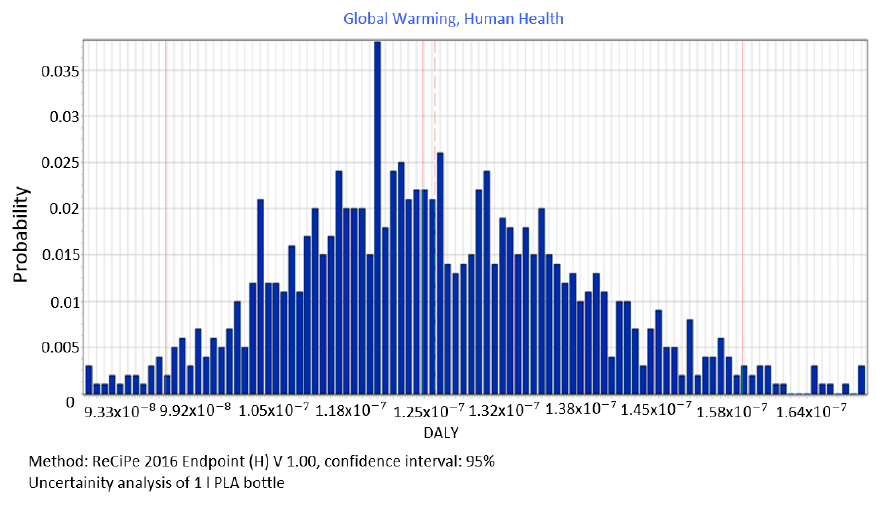
Figure 9. Results of the uncertainty analysis for the category of global warming and its impact on human health.